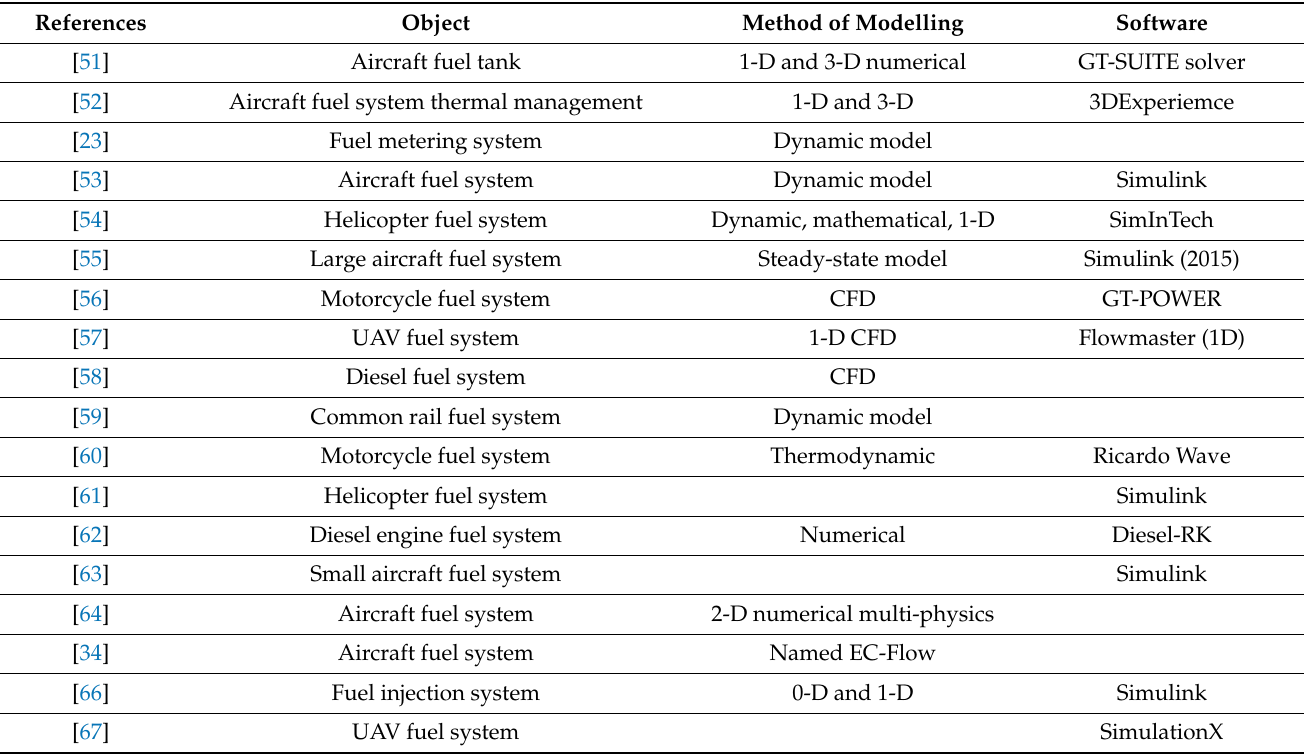
Table 2. The simulation work reviewed in Section